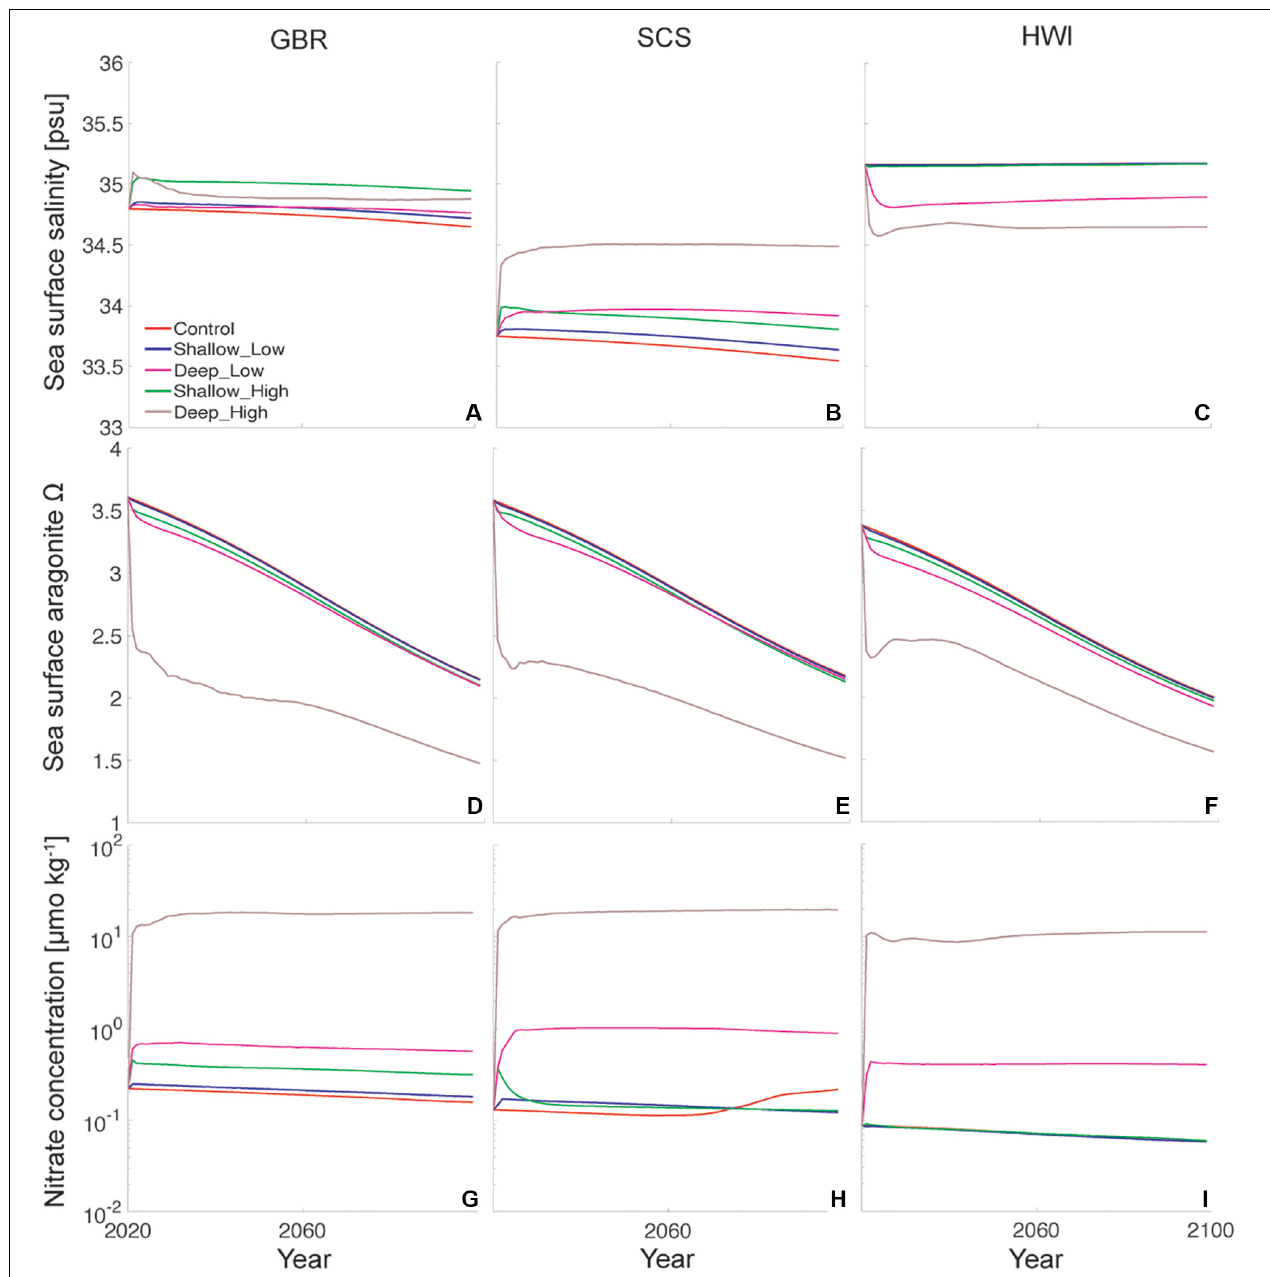
FIGURE 4 | For the Great Barrier Reef (GBR), South China Sea (SCS), and Hawaii (HWI) regions, the time series of area-averaged annual mean sea surface salinity (A–C) , aragonite saturation level ( (cid:127) -Arag, D–F ), and nitrate concentration (G–I) , where artificial upwelling was